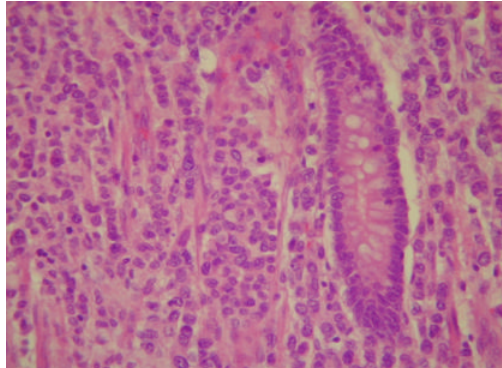
Figure 2: CT scan reveals left hydronephrosis secondary to com- pression on lower ureter by a rectal mass, previous right nephrecto- my.